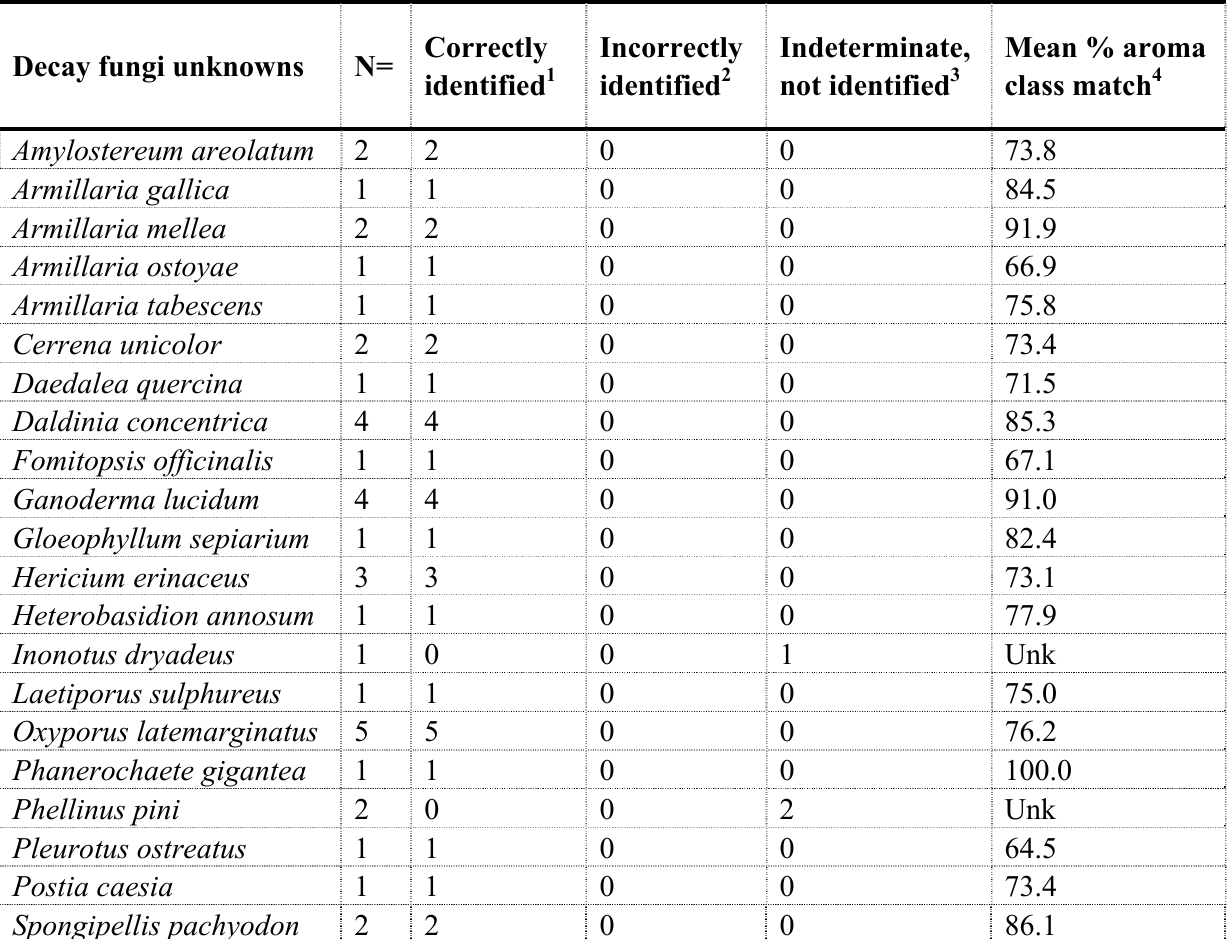
Table 4. Tests of the capability of the AromaScan A32S e-nose to identify 24 wood decay fungi in pure agar culture using conductive polymer analysis with recognition files constructed from a fungus-specific reference